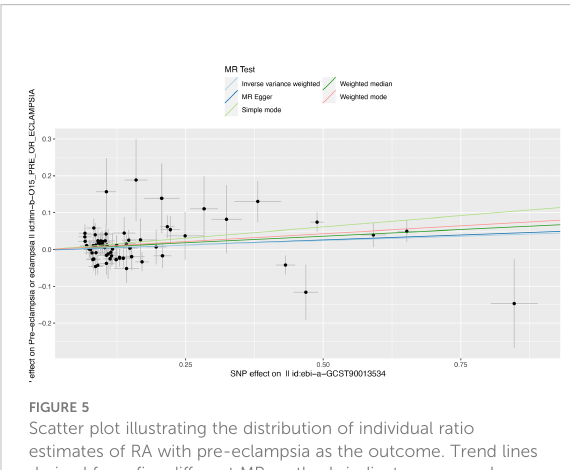
FIGURE 5 Scatter plot illustrating the distribution of individual ratio estimates of RA with pre-eclampsia as the outcome. Trend lines derived from fi ve different MR methods indicate cause and effect. Inverse variance weighted(light blue), Weighed median (dark green), MR Egger(dark blue), weighted mode(red), Simple mode(light green); SNP, single-nucleotide polymorphism; RA, rheumatoid arthritis; MR, mendelian